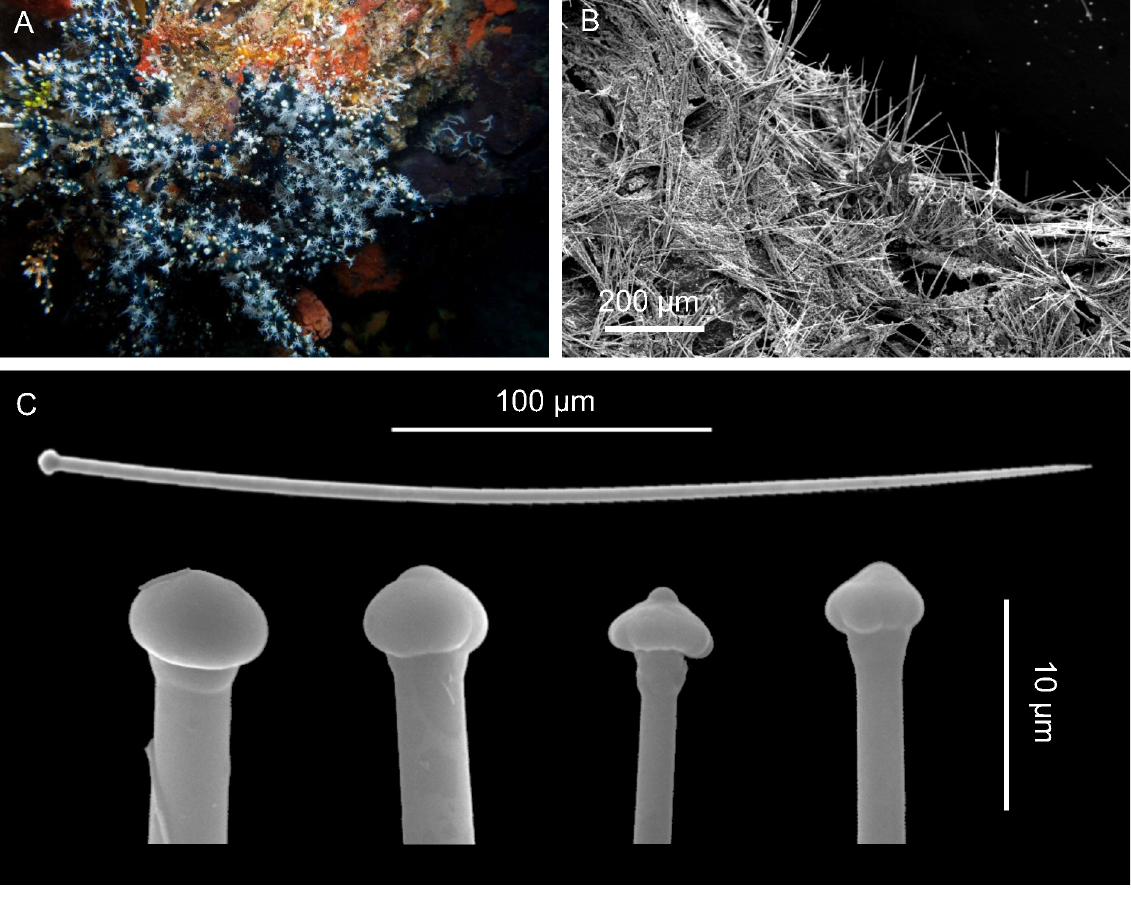
Fig. 26. Terpios granulosus Bergquist, 1967. A . Sponge ( PO96) encrusting the octocoral Carijoa sp. B . Tylostyles organized in brushes (SEM). C . Tylostyle and magnification of heads, different in